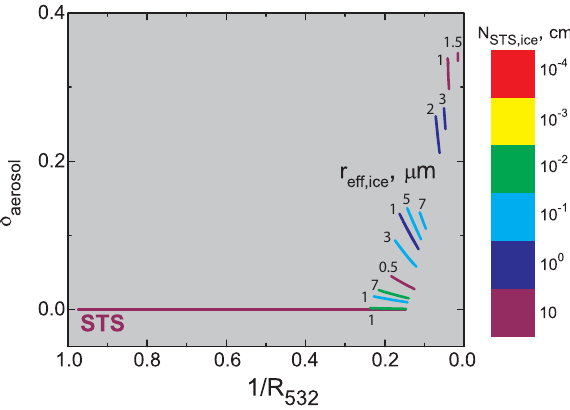
Fig. 6. Theoretical results for STS and mixtures of STS with ice. Color scale=particle number